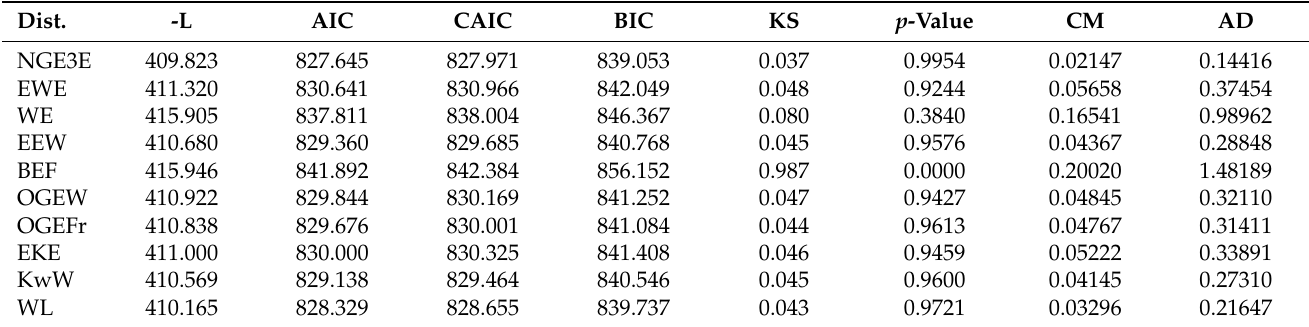
Table 6. GFMs of CMs for bladder-cancer